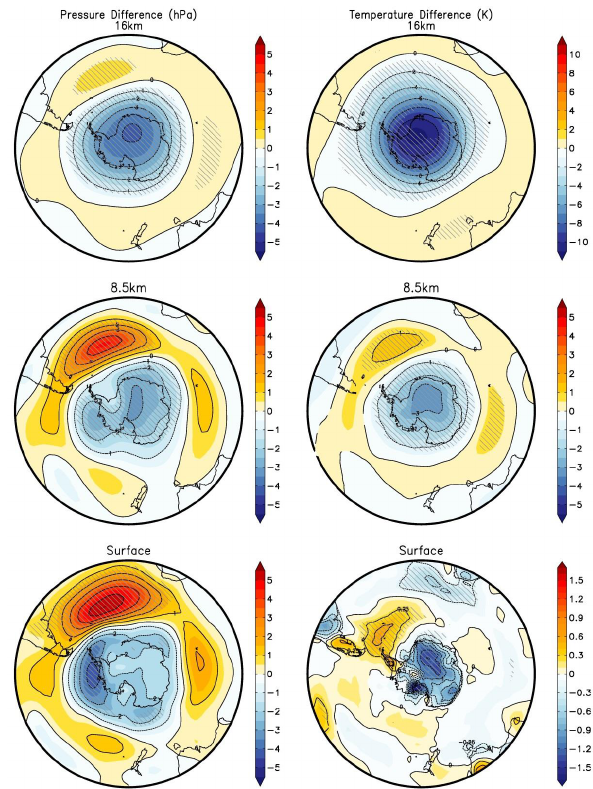
Figure 10: Stereographic plots of December pressure (left) and temperature (right) differences 2 Figure 10. Stereographic plots of December pressure (left) and tem- between REF2000 and NHC at 16 km (top), 8.5 km (middle) and the surface (bottom). Note 3 perature (right) differences between REF2000 and NHC at 16km the different scales for the temperature response at different altitudes. Hatching denotes 4 (top), 8.5km (middle) and the surface (bottom). Note the different significance at the 95% confidence level. 5 scales for the temperature response at different altitudes. Hatching denotes significance at the 95% confidence